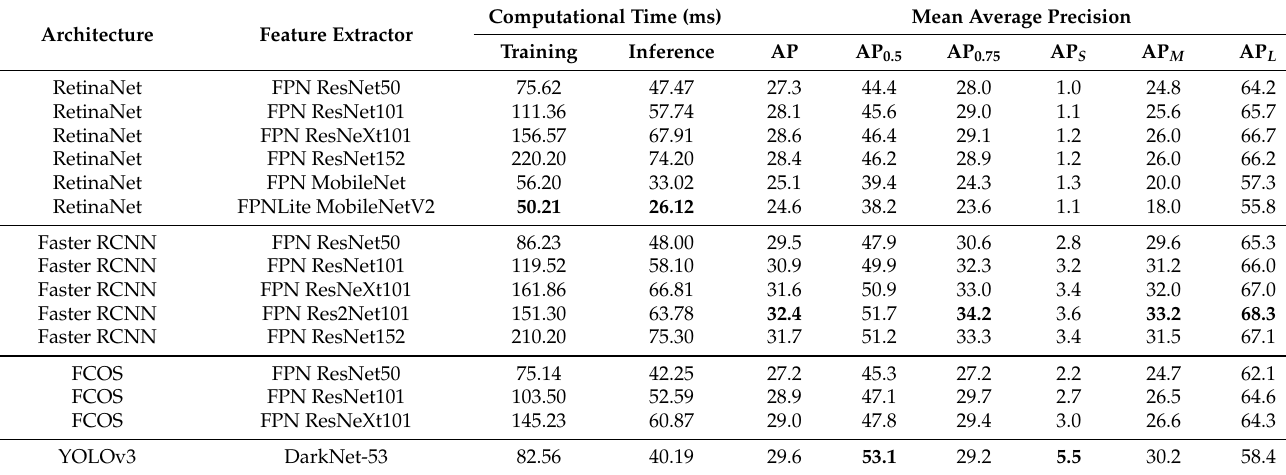
Table 5. COCO precision metrics and computation time of all models with low-resolution images. S, M, and L indicate small, medium and large objects respectively. The best results are highlighted in bold. Architecture RetinaNet